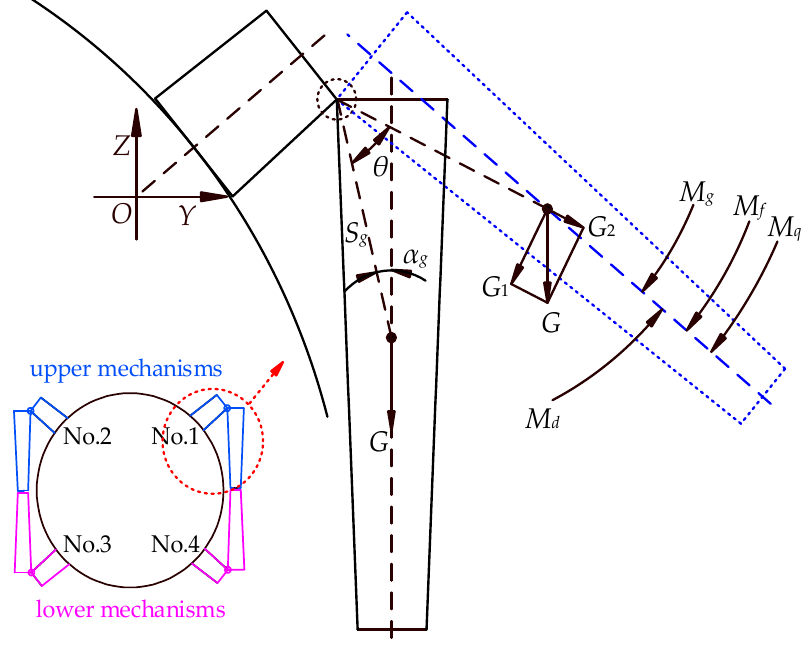
Figure 2. Force diagram of folding wing.